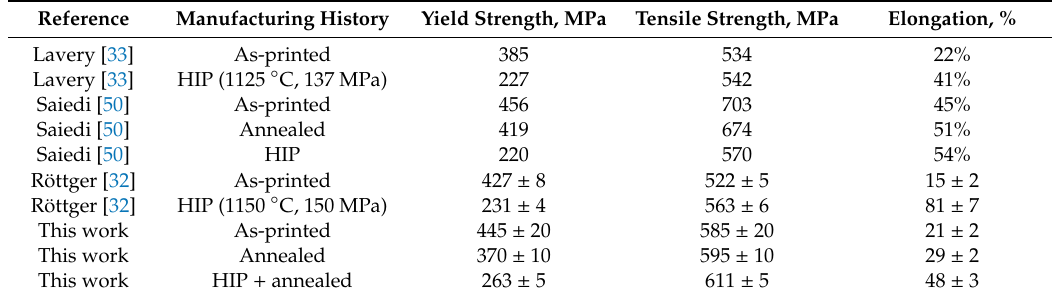
Table 3. Comparison of the results (this work) with the published data on additively manufactured 316L steel.